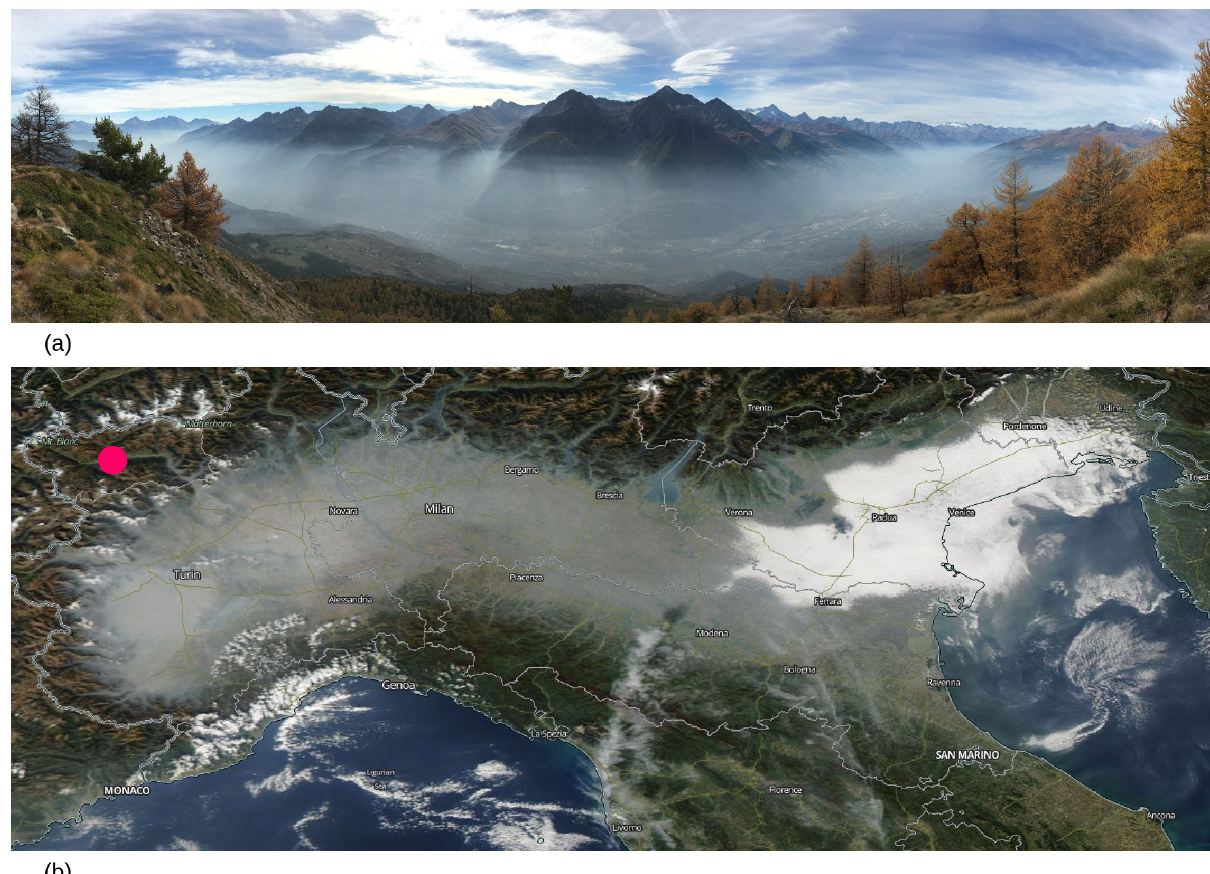
Figure 1. (a) Panoramic view of the main valley over the Aosta–Saint-Christophe station during a pollution advection event. The picture was taken from Croce di Fana (2200ma.s.l., Quart village, 6km northeast of Aosta–Saint-Christophe) on 21 October 2017. On that day, the advected layer of aerosol – visible in the picture as a hazy layer – reached an altitude of about 2000ma.s.l. Photo kindly provided by Corrado Cometto. (b) Image of the Po Valley from the MODIS Aqua radiometer (corrected reflectance, true colour) only a few days before the picture in (a) was taken (18 October; https://worldview.earthdata.nasa.gov, last access: 28 February 2019). The satellite view clearly shows that the hazy aerosol-rich layer from the Po basin is starting to pour out into the Alpine valleys. The pink marker identifies the Aosta–Saint-Christophe